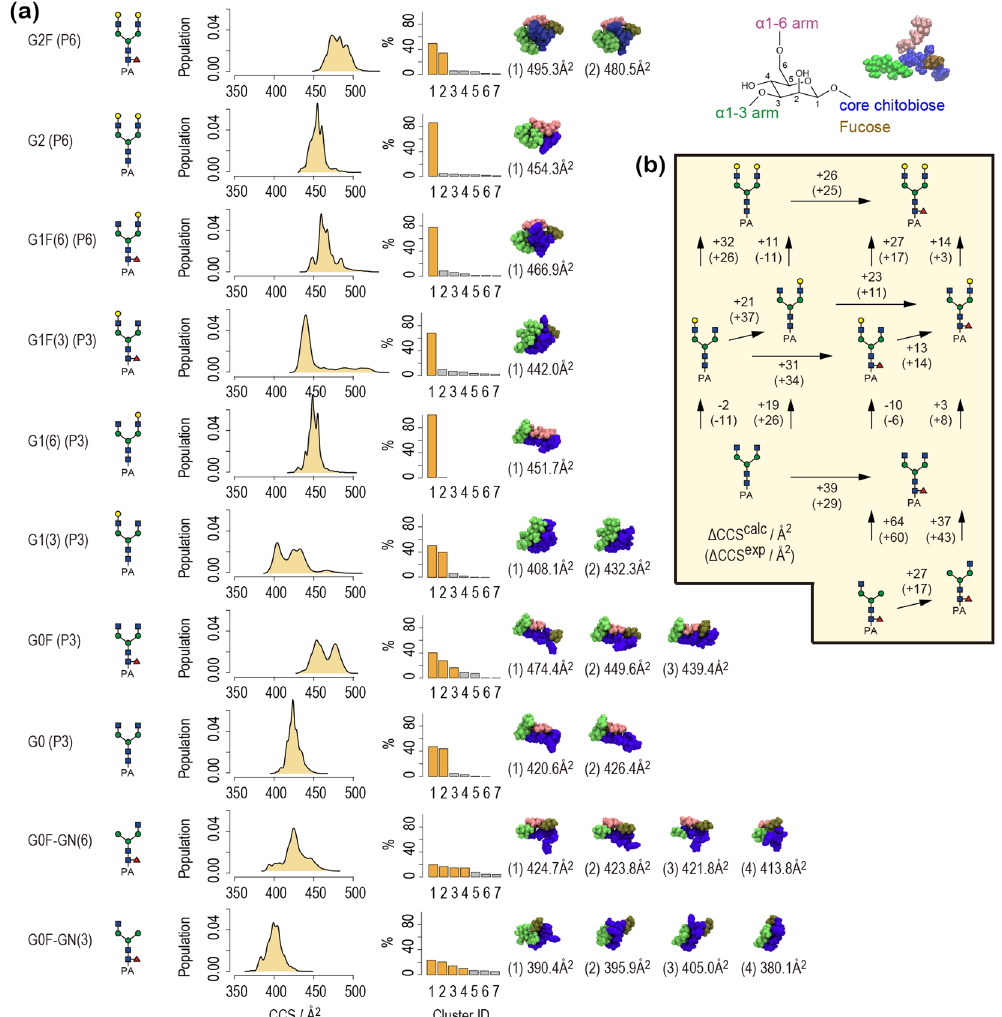
Figure 3. ( a ) CCS distributions, cluster populations that were obtained from k-means clustering using MMTSB toolset (threshold: RMSD = 2.5 Å), and major conformers making up more than 10% of the population (orange bars). The CCS values of major conformers are also given. Blue, green, red, and gold colors for the core chitobiose, α 1-3 arm, α 1-6 arm, and fucose residue respectively. ( b ) Differences in CCS values ( Δ CCS calc ) are listed with the corresponding values from experiment ( Δ CCS exp